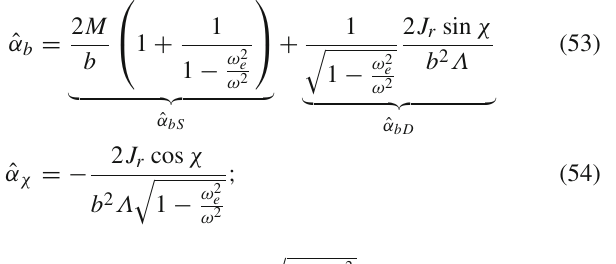
becomes very small, and both angles behave in the same way since 2 J r sin χ/( nb 2 Λ) → 0 when b / 2 M → ∞ . /ω 2 .Thebehav- Figure1rightshows ˆ α b asafunctionof ω 2 e ior is very similar to that of Schwarzschild (Fig. 1 left). How- ever, note that there is a small increment for b / 2 M =